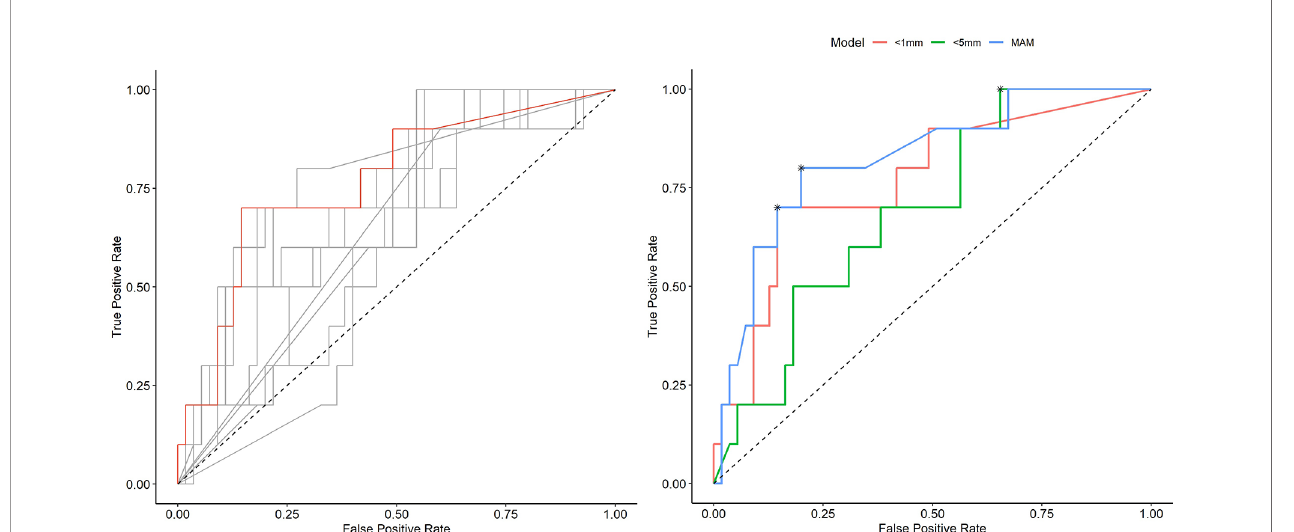
FIGURE 4 | Receiver operating characteristic (ROC) curves illustrating the diagnostic ability of varying outputs of three-dimensional quantitative ablation margins (3D- QAMs). Left: All ROC curves with percentages of tumor coverage of least 0, 1, 2, 3, 4, 5, 6, 7, 8, 9, or 10 mm. The highest accuracy [area under the curve (AUC) = 0.77] in predicting ablation site recurrence (ASR) was found for the tumor coverage of 1 mm indicated in red. Right: Blue curve, minimal ablation margin (MAM); red curve, percentages of tumor coverage <1 mm; green curve, percentages of tumor coverage <5 mm. Optimal discrimination thresholds of each curve are indicated with an asterisk